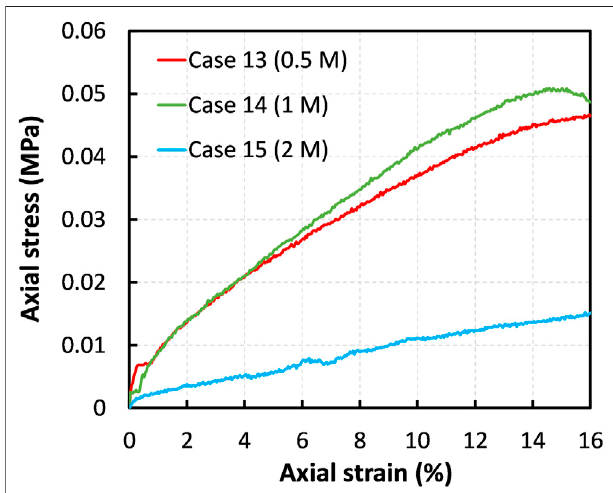
FIGURE 8 | Effect of the MICP binder dosage on strengthening of the treated amorphous peat: comparison between the cases 13 – 15.